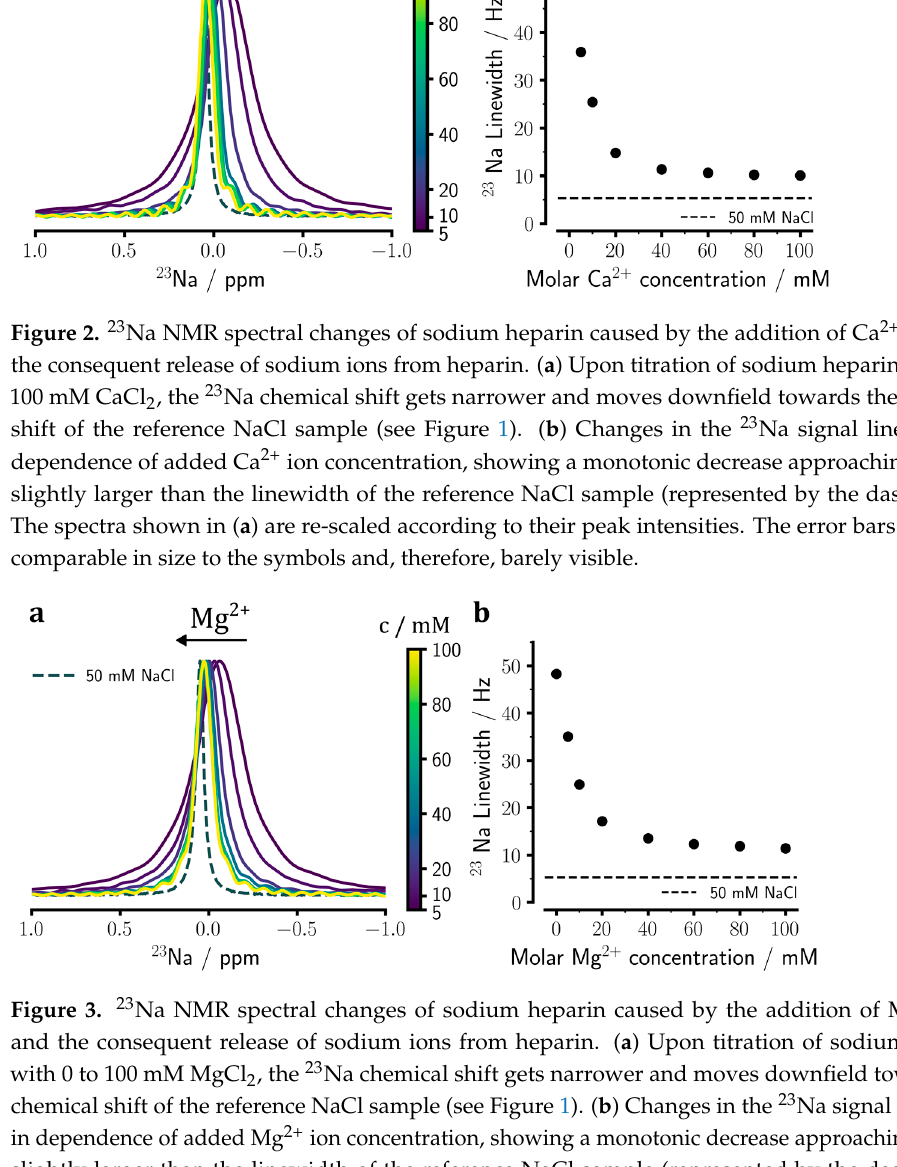
of added Ca 2+ ion concentration, showing a monotonic decrease approaching a value slightly larger than the linewidth of the reference NaCl sample (represented by the dashed line). The spectra shown in ( a ) are re-scaled according to their peak intensities. The error bars in ( b ) are comparable in size to the symbols and, therefore, barely visible.